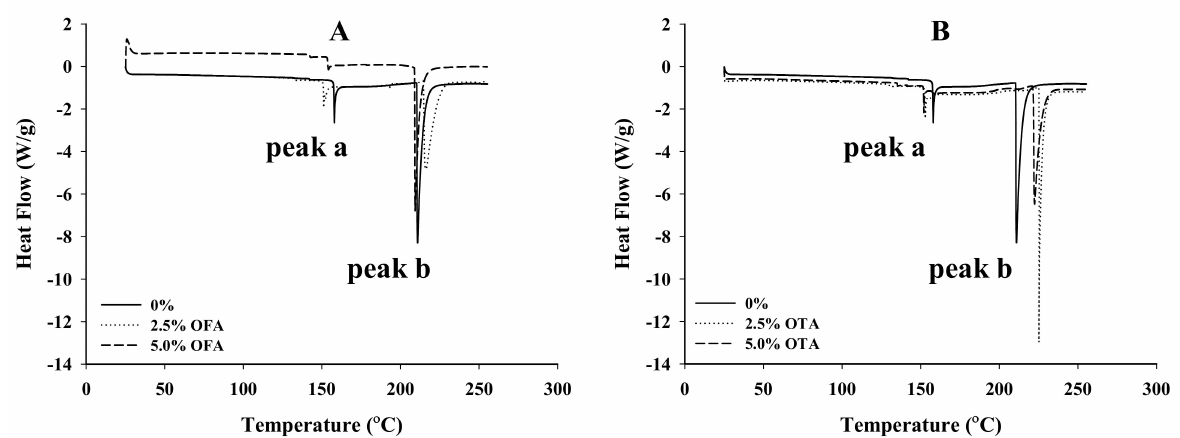
Figure 3. Differential scanning calorimetry thermograms of 2.5% and 5.0% oxidized ferulic (OFA; A ) and tannic (OTA; B ) acid-treated WPI